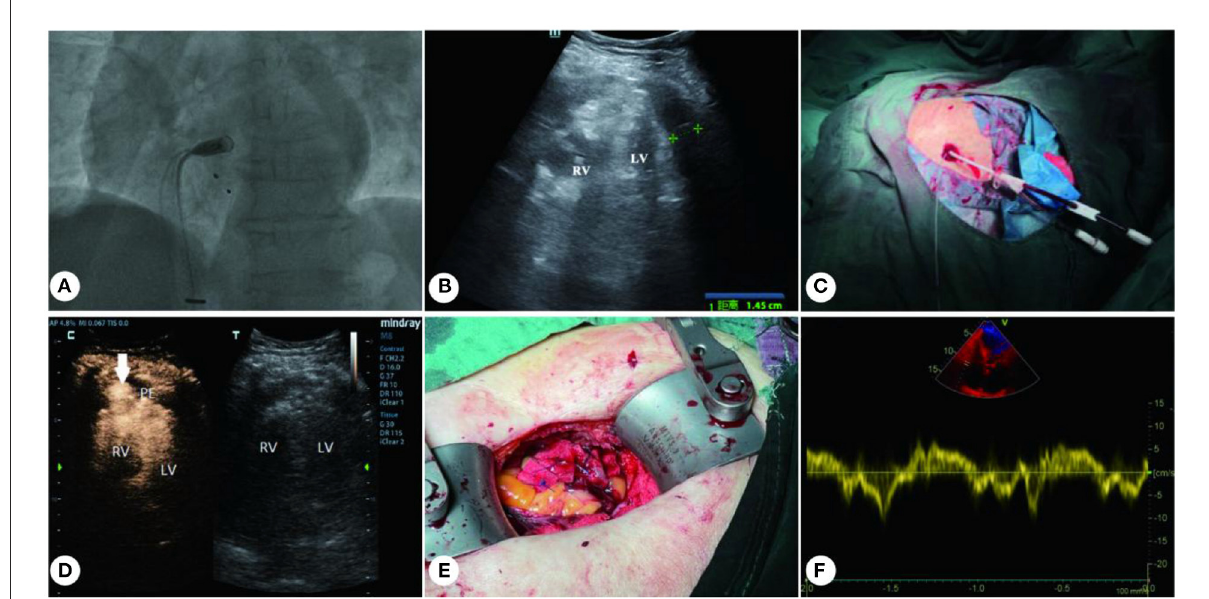
FIGURE1 Treatment for iatrogenic right ventricular perforation. (A) Delivery system carrying the MLP to right ventricle. (B) Medium-volume effusion in the pericardial cavity. (C) 12F pigtail catheter placed (under ultrasound guidance) into the pericardial cavity. (D) CEUS shows right ventricular free wall perforation (with arrow indication). (E) 3-0 prolene with spacers were used to close the RV perforation. (F) Recovery of cardiac function after surgery. RV, right ventricle; LV, left ventricle; PE, pericardial